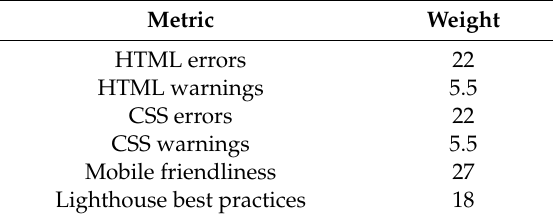
Table 2. Weights for the calculation of the website structure evaluation